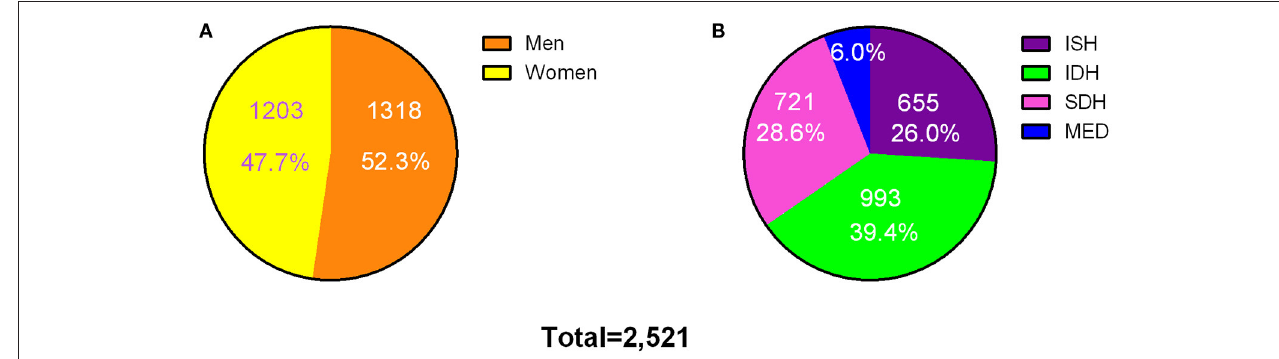
FIGURE 2 | Incident cases of hypertension and subtypes among the participants. Incident cases of hypertension by gender (A) and subtypes (B) . ISH, isolated systolic hypertension; IDH, isolated diastolic hypertension; SDH, systolic-diastolic hypertension; MED, currently using antihypertensive medication.